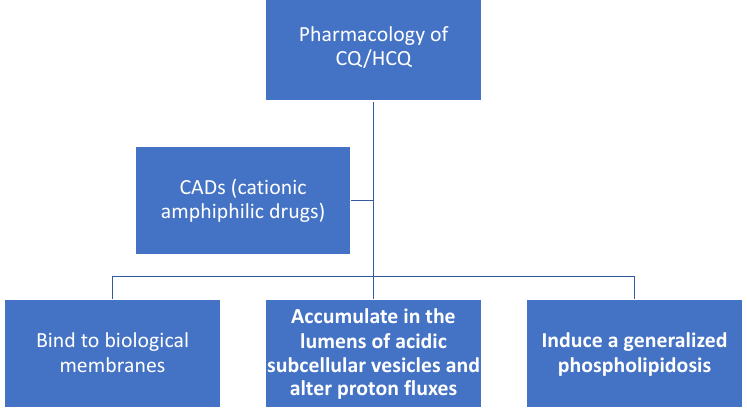
Figure 2. Chloroquine (CQ) and hydroxychloroquine (HCQ) are cationic amphiphilic drugs (CADs) that share a set of common pharmacological properties: (a) they can partition into biomembranes; (b) accumulate in the lumens of acidic subcellular organelles, and; (c) induce a generalized phospholipidosis, which is the lysosomal accumulation of phospholipids.